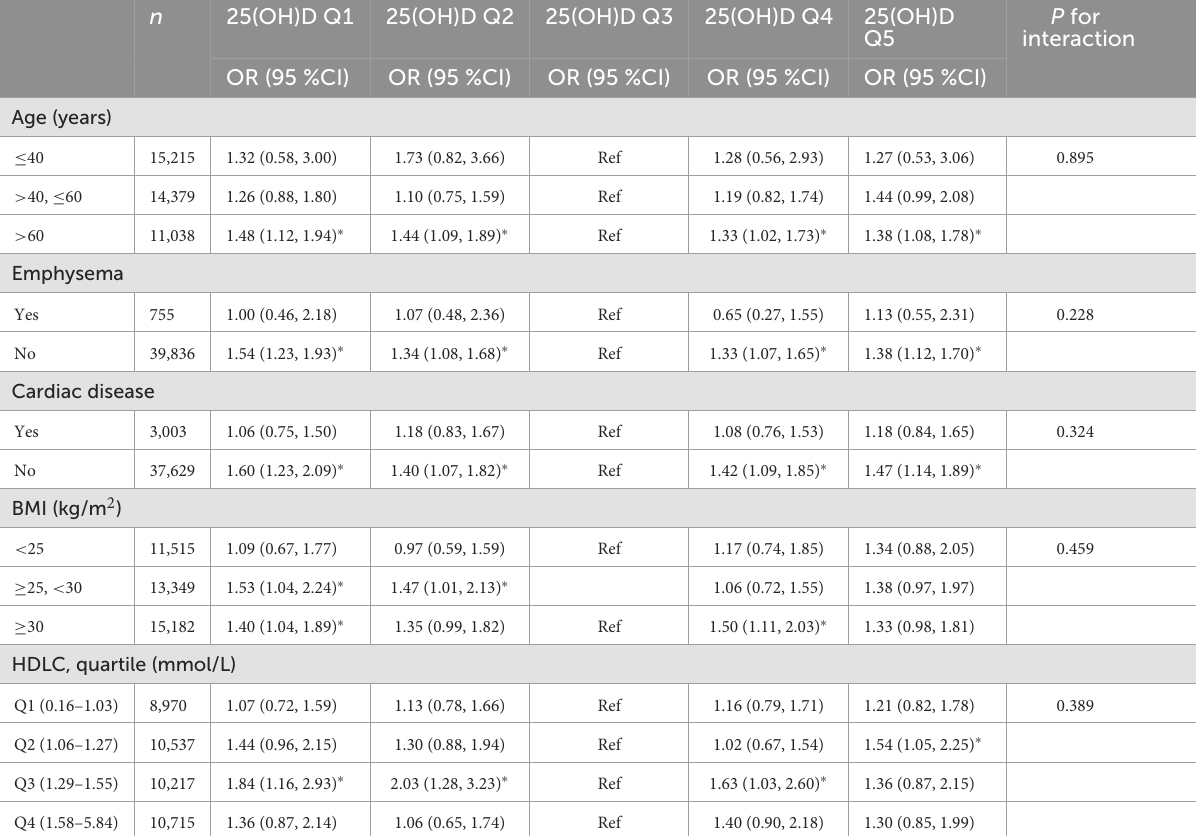
TABLE 5 Adjusted odds ratio for the association of 25(OH)D and stroke history in subgroups by age, emphysema, cardiac disease, BMI, and